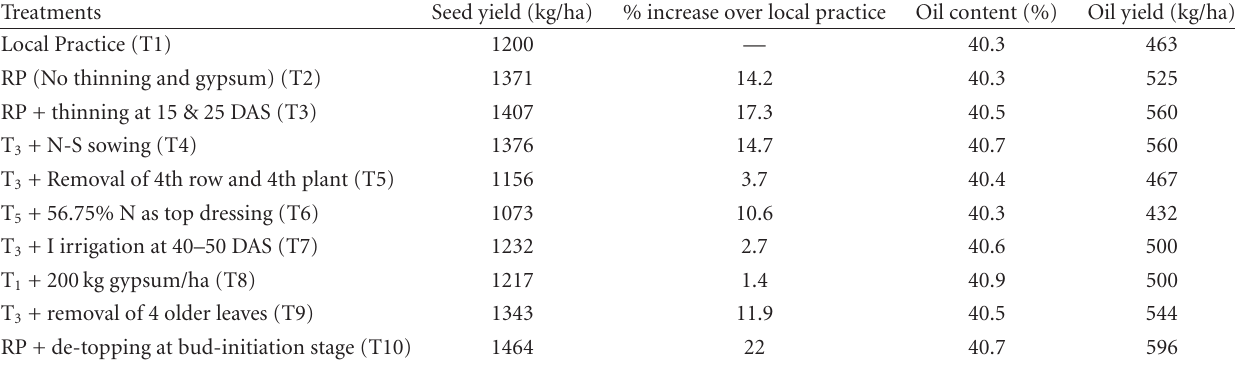
Table 13: E ff ect of low monetary agrotechniques on seed yield and oil content of mustard at Bharatpur during 1997-1998. Treatments Seed yield (kg/ha) % increase over local practice Oil content (%) Oil yield